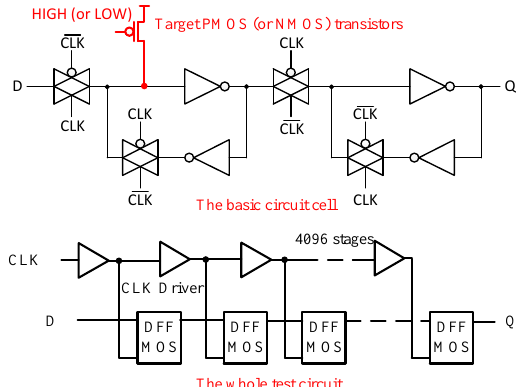
Figure 1. The basic TAISAM cell contains a flip-flop and a target transistor. Several TAISAM cells consist of an entire test